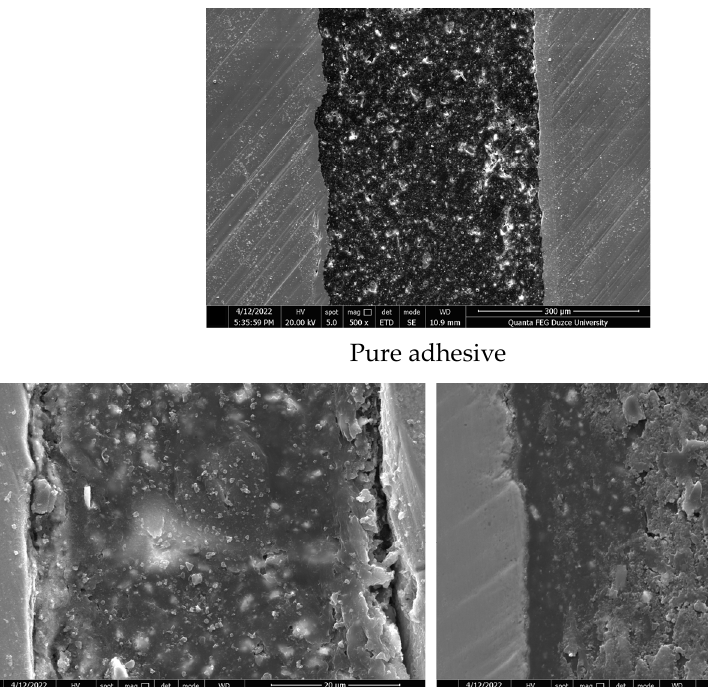
Figure 1. SEM images of powders. Figure 4. SEM images of powders.